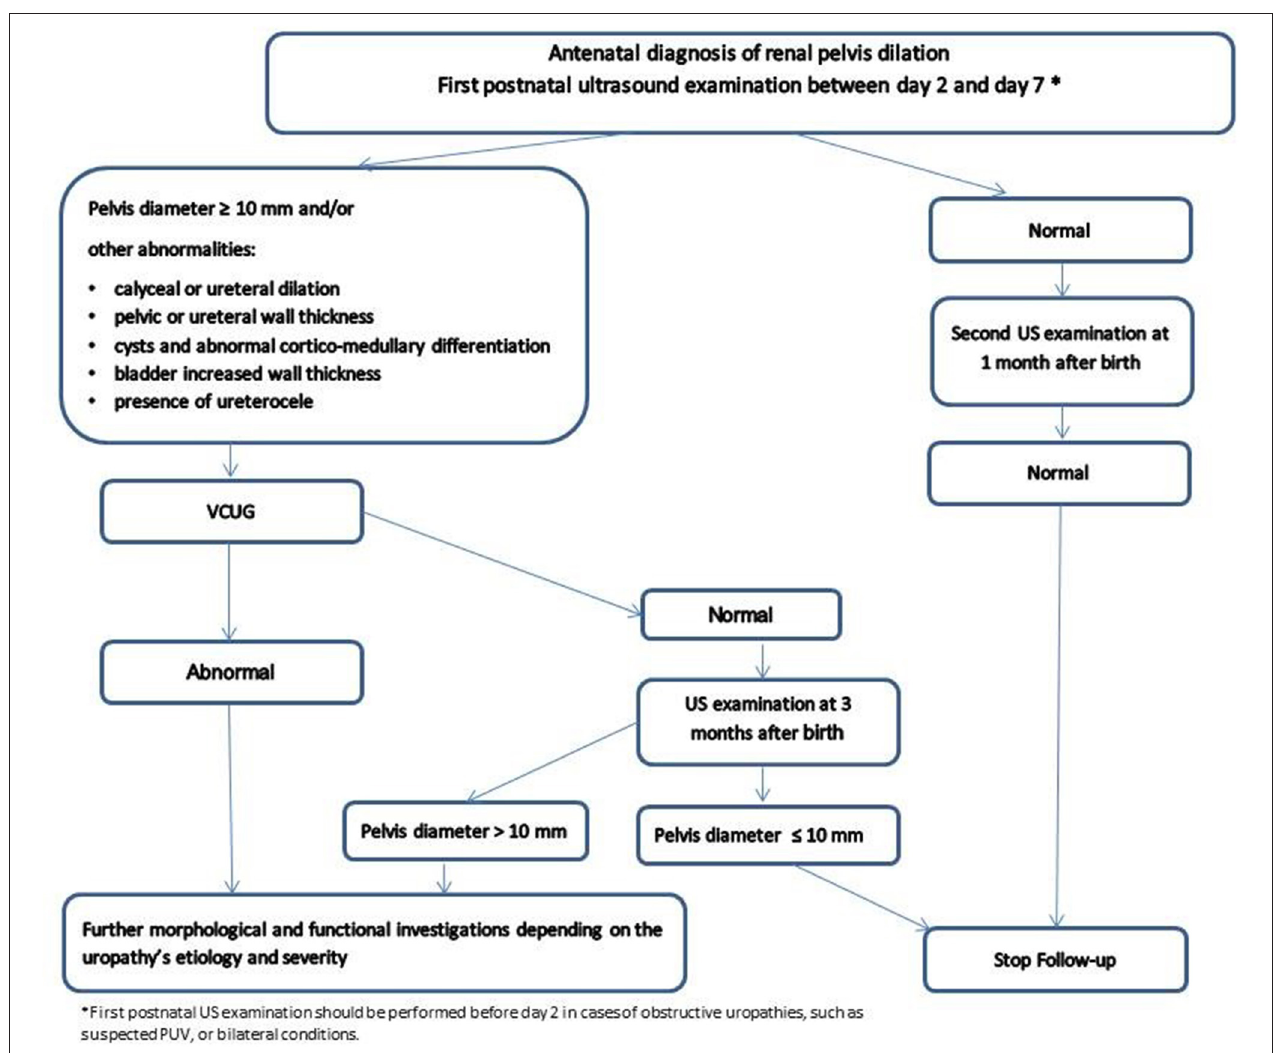
FIGURE 1 | Antenatally detected urinary tract dilation and post-natal imaging